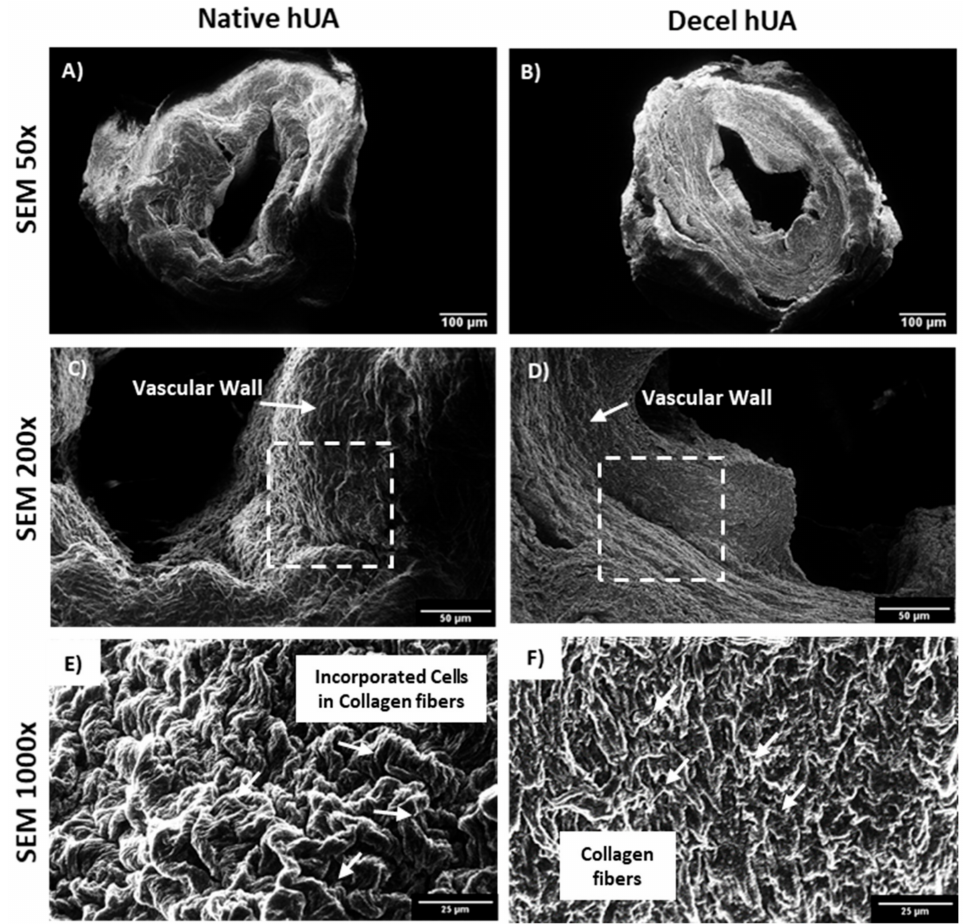
Figure 2. SEM histological analysis of hUAs. SEM images of native ( A , C , E ) and decellularized ( B , D , F ) hUAs. White arrows in images ( A , D ) represent the vascular wall. White squares in the same images represent the magnified region, as presented in images ( E , F ). White arrows in image E represent the combination of cells and collagen fibers of native, while in Figure F , white arrows represent only the preserved collagen fibers of decellularized hUAs. Images were presented with original magnification 50 × ( A , B ), scale bars 100 µ m, 200 × ( C , D ), scale bars and 1000 × ( E , F ), scale bars 25 µ m.